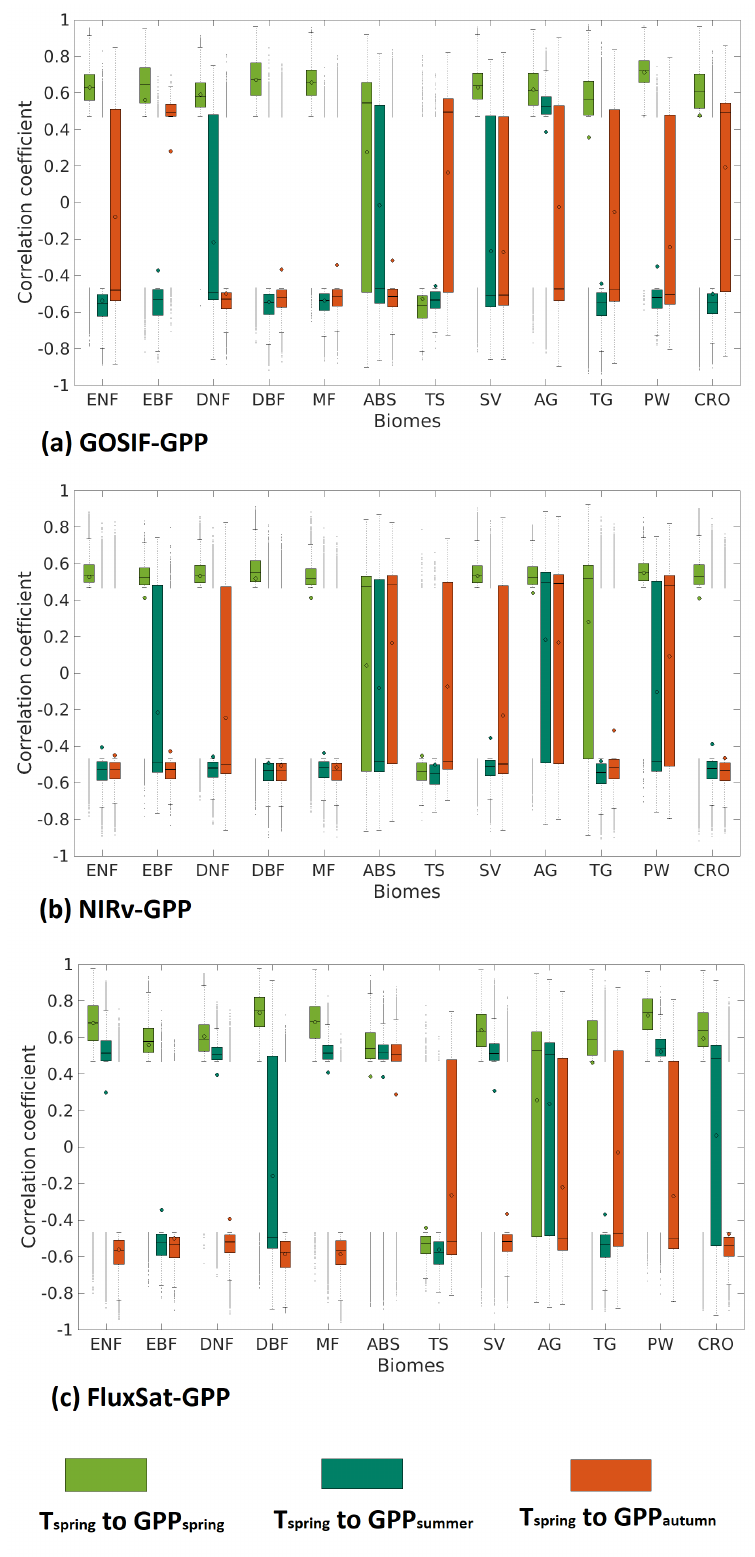
Figure 4. Boxplot of T spring correlation coefficients to GPP spring , GPP summer , and GPP autumn (spring: light green, summer: green and autumn: orange), for: ( a ) GOSIF-GPP, ( b ) NIRv-GPP, and ( c ) FluxSat- GPP. The mean value is represented by a small circle, and the median by a